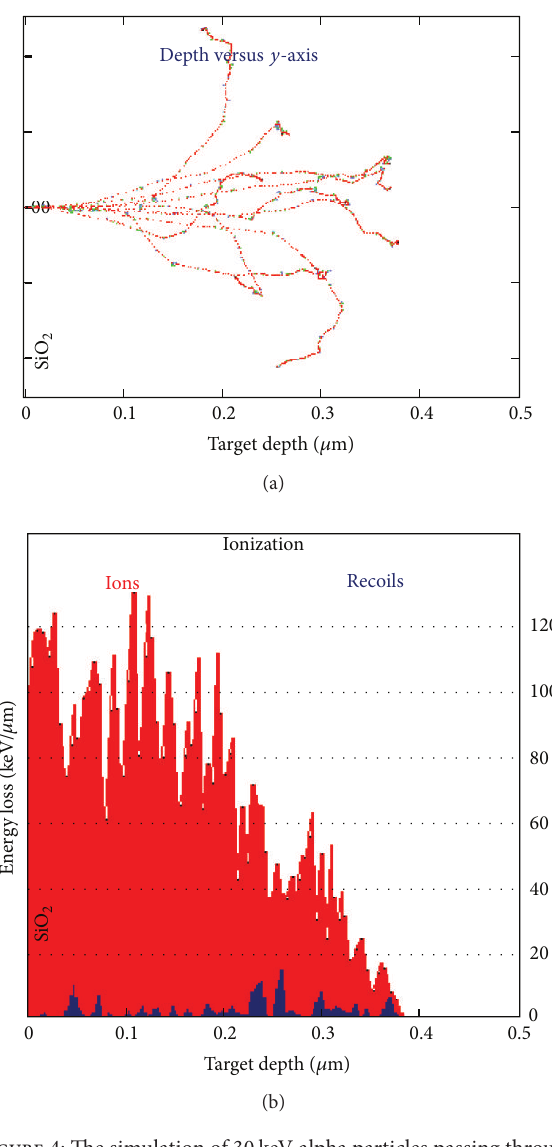
Figure 4: The simulation of 30keV alpha particles passing through 0.5 𝜇 m thick layer of SiO 2 (10 events). (a) Trajectory of alpha particles in 𝑥𝑂𝑦 plane. (b) The ratio of specific ionization (linear transfer of energy) of incident alpha particles and displaced Si and O atoms along the oxide